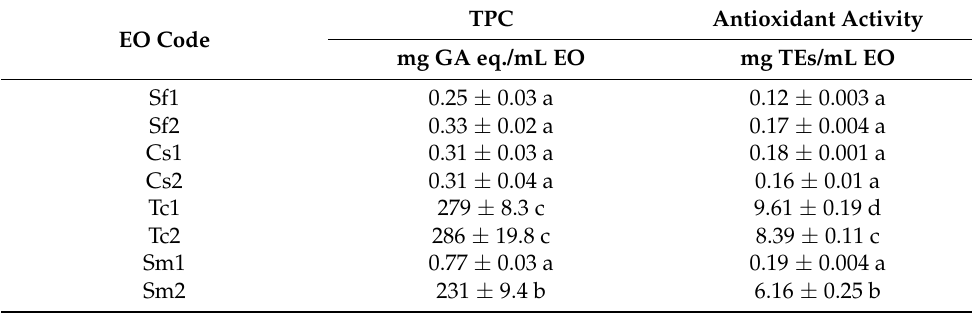
Table 3. Total phenolic content (TPC) and antioxidant activity of